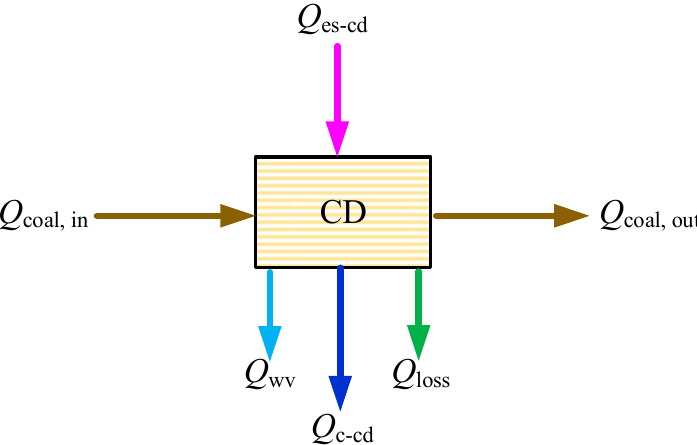
Figure 3. Energy balance of the coal drier during the coal pre-drying process.